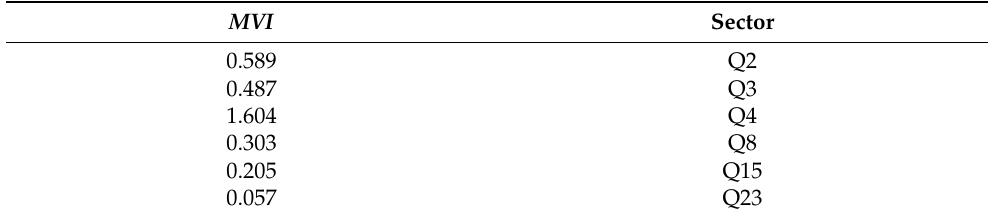
Table 2. MVI values of the representative six sectors extracted potentially corresponding to different seabed morphological complexities.